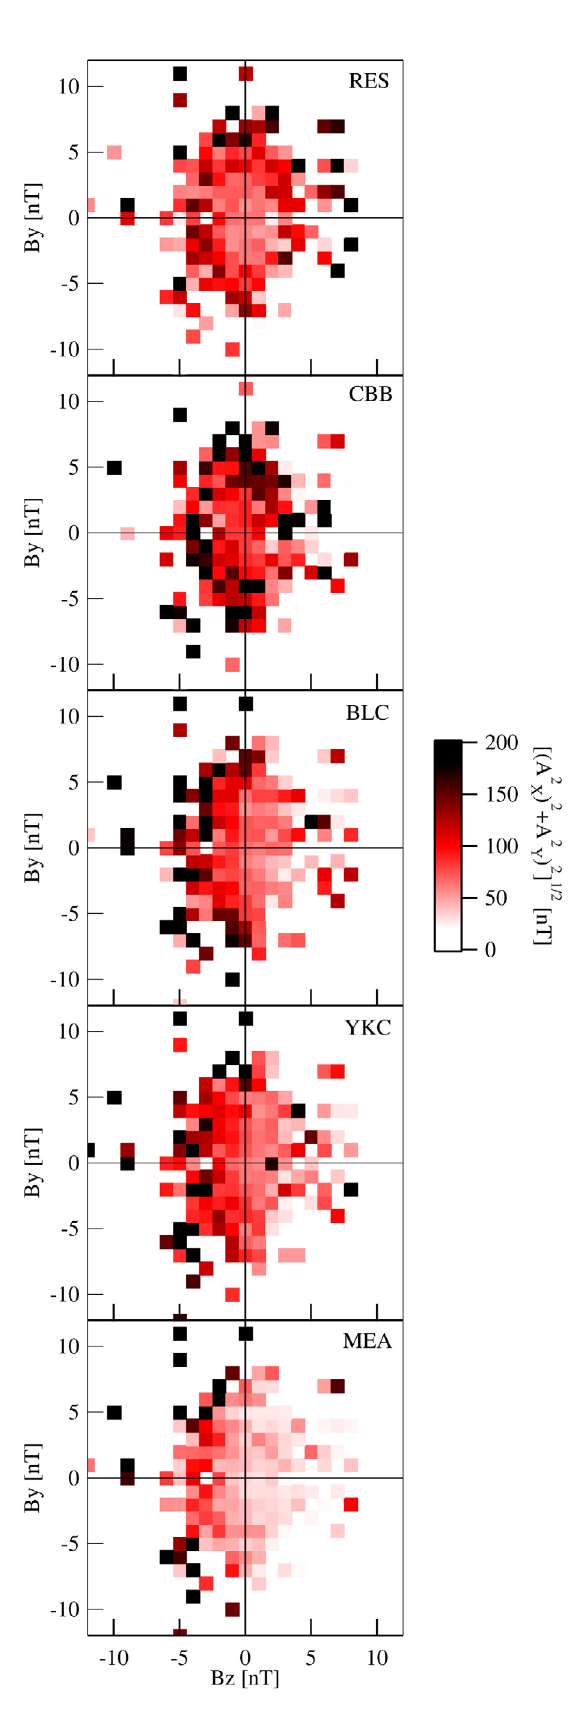
Figure 6. The amplitude module of the equivalent current vec- tors calculated by means of the first mode as a function of the B and B values for each geomagnetic observatory considered in z this study.